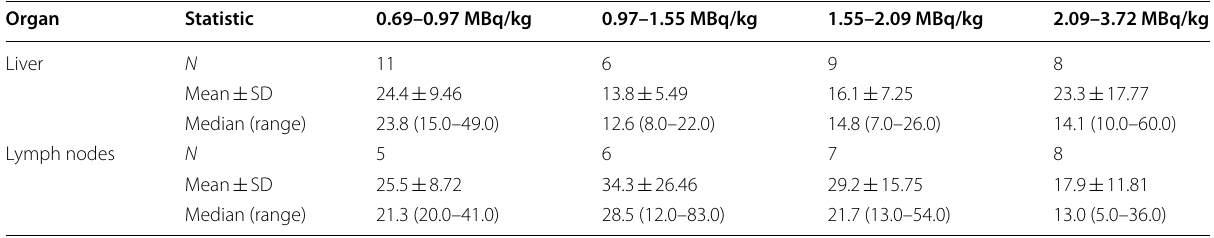
Table 6 SUV of the liver and lymph nodes, by radioactivity per patient’s body weight max